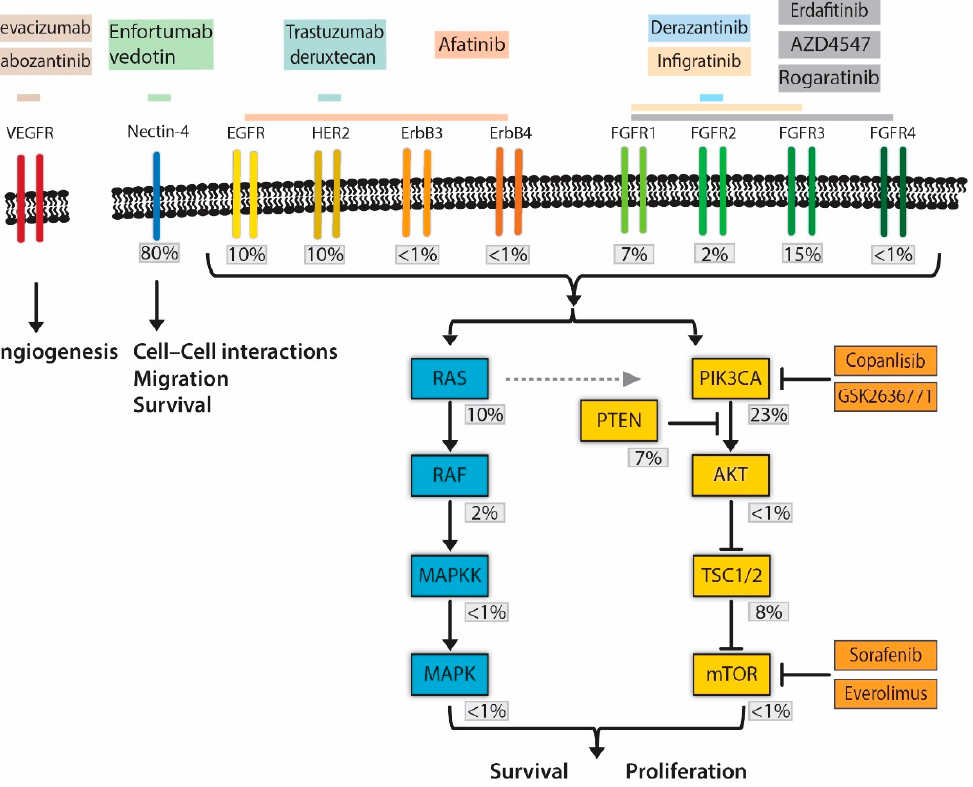
Figure 1. Therapeutic targets in muscle-invasive bladder cancer (MIBC). Schematic overview of (RTK)/MAPK (blue) and (RTK)/PI3K/AKT/mTOR (yellow) pathway alterations that are frequently detected in MIBC patients. Gene alteration frequencies are indicated as percentages under the corresponding proteins. Therapeutic agents that target particular or multiple RTKs are shown above their corresponding targets. Therapeutic agents targeting PIK3CA or mTOR (orange) are depicted next to their targets.